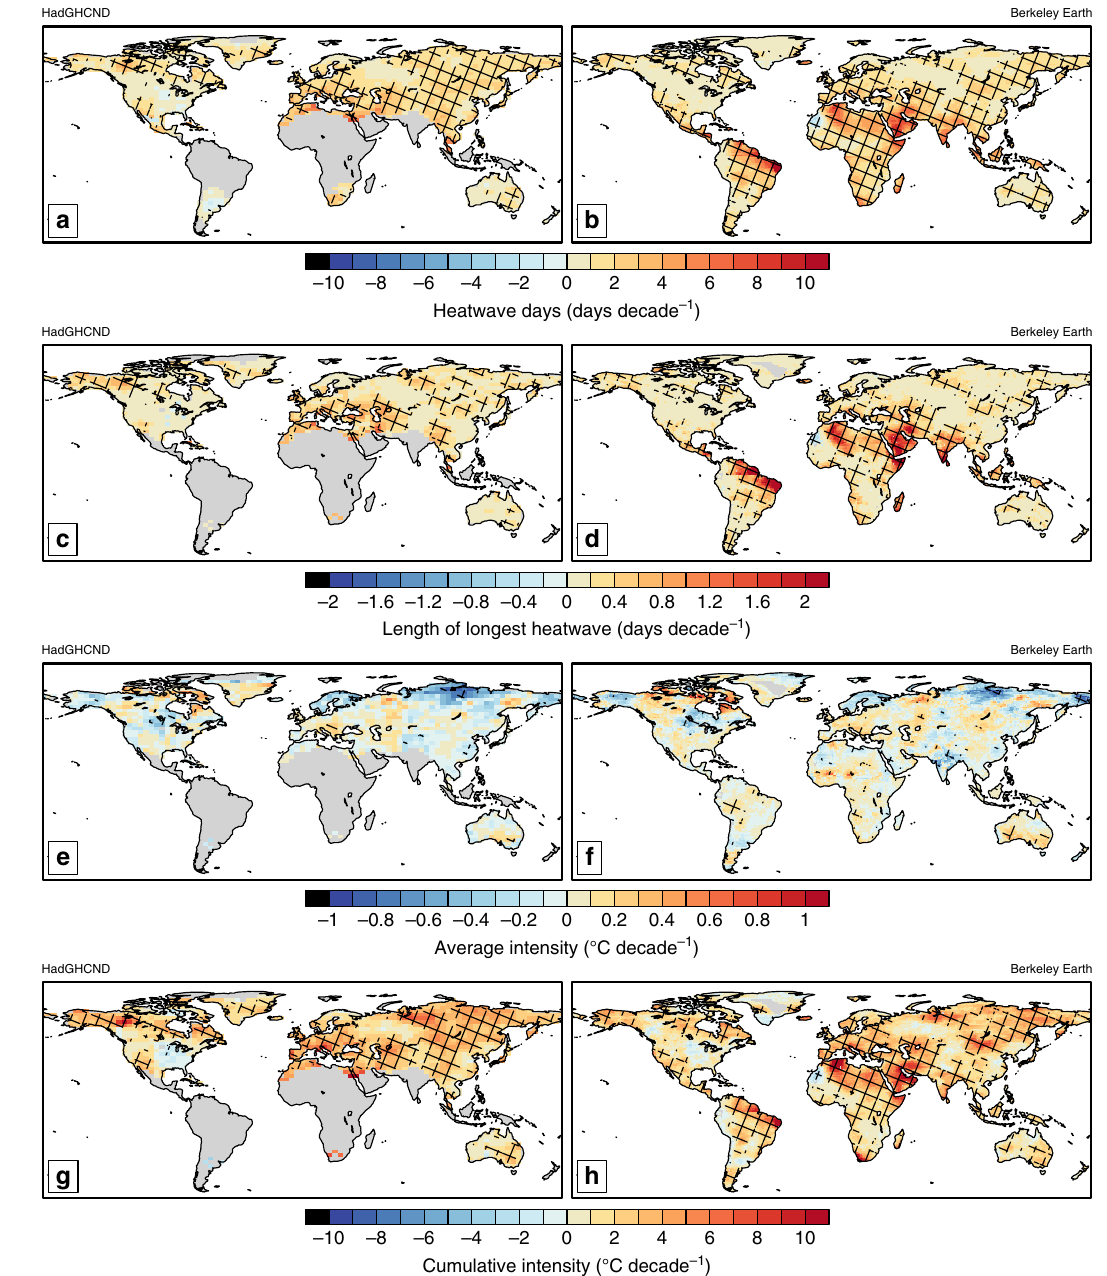
Fig. 1 Global maps of observed decadal heatwave trends. Trends in seasonal heatwave days ( a , b ); length of longest heatwave ( c , d ); average heatwave intensity ( e , f ); and cumulative heat ( g , h ) for quasi-global observational dataset HadGHCND ( a , c , e , g ) and global observational dataset Berkeley Earth ( b , d , f , h ) over the period 1950 − 2014. Trends are expressed as days decade − 1 for ( a − d ), and °C decade − 1 for ( e − h